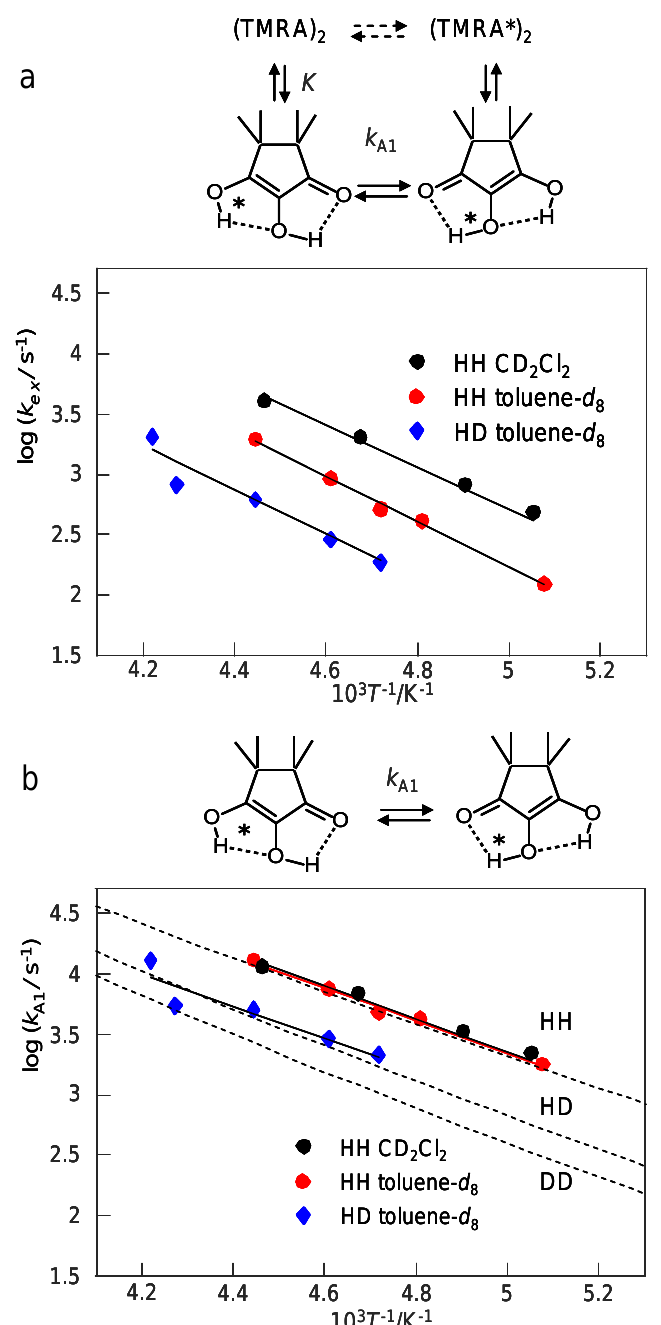
Figure 13. ( a ) Arrhenius diagram of the pseudo-first-order rate constants k ex of the tautomerism of TMRA in solution. The values of k ex were obtained by line shape analysis (Figures 9–11, Table 2) and refer to the temperature-dependent mixture of monomers and dimers. ( b ) Arrhenius diagram of the first-order rate constants k A1 of the tautomerism of TMRA in solution. The values of k A1 were obtained from the values of k ex using Equation (10). The hatched curves were calculated using the tunneling model described in Section 4.5.